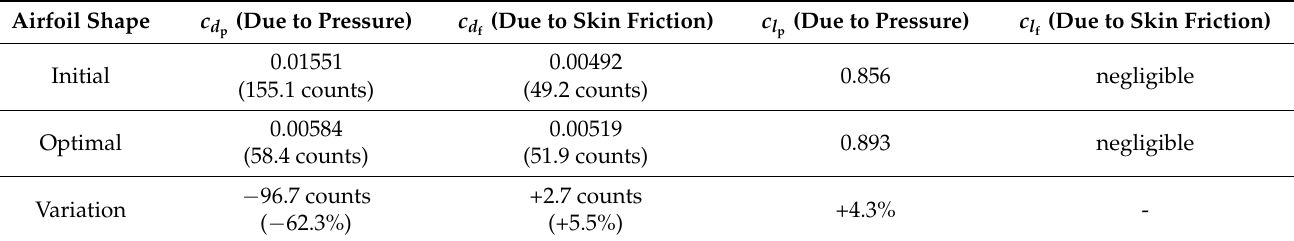
Table 3. The value of the components of the drag (drag due to pressure and drag due to skin friction) for the initial and optimal shapes (Test case II).